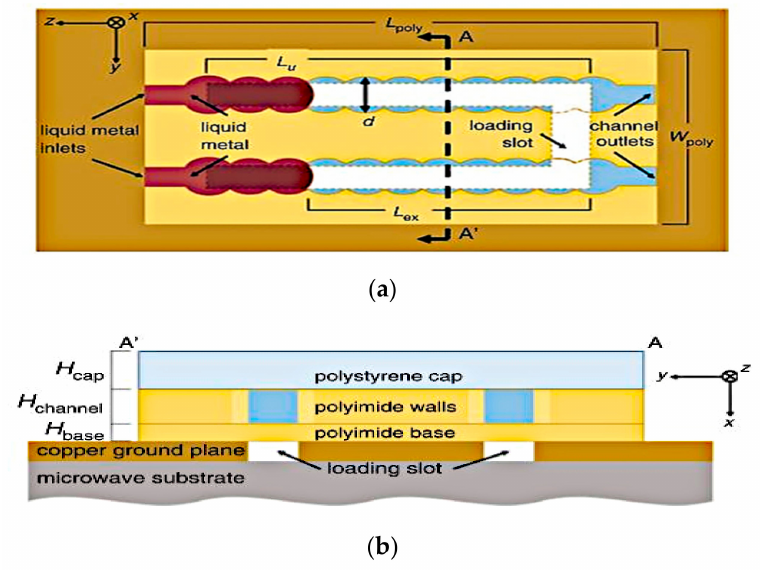
Figure 13. ( a ) Frequency-tunable antenna. ( b ) Cross section of the microfluidic channel structure